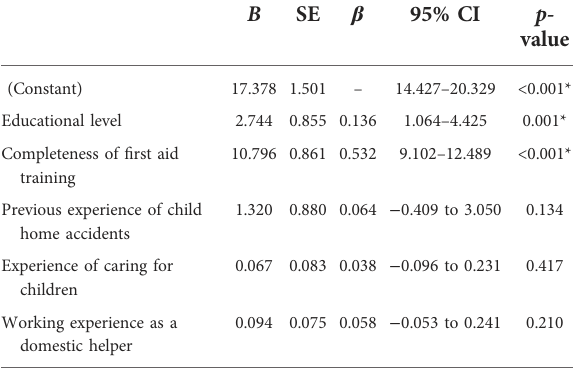
TABLE 4 Multiple linear regression of the predictors for self-ef fi cacy of providing emergency management to children involved in home accidents ( N